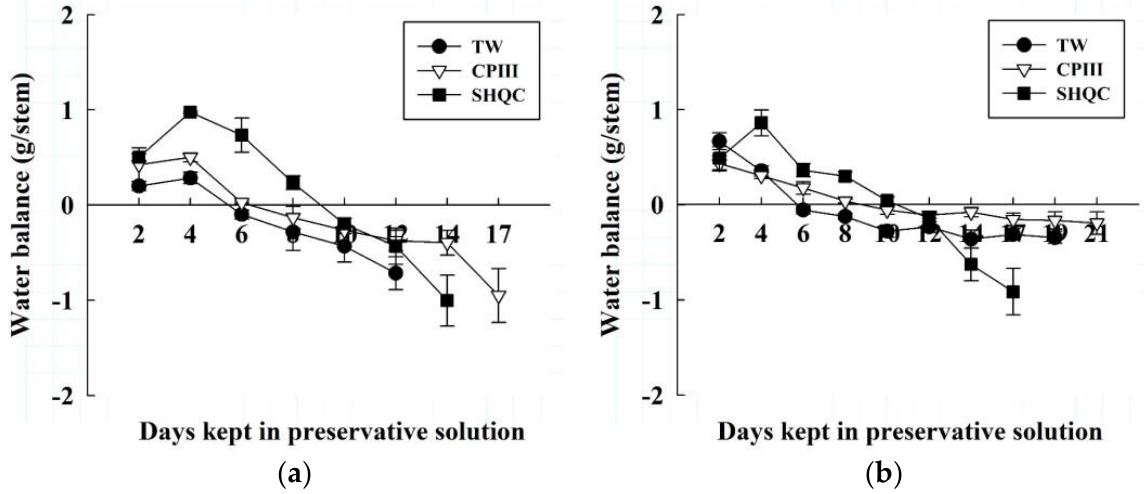
Figure 4. Changes in the water balance of cut hydrangea flowers ‘Verena’ kept in each preservative solution treatment in ( a ) 2019 and ( b ) 2020. Vertical bars indicate standard deviation of means ( n = 9). TW, tap water; CPIII, 1% Chrysal Professional III; and SHQC, 2% sucrose + 250 mg/L 8-hydroxquinoline + 100 mg/L citric acid.